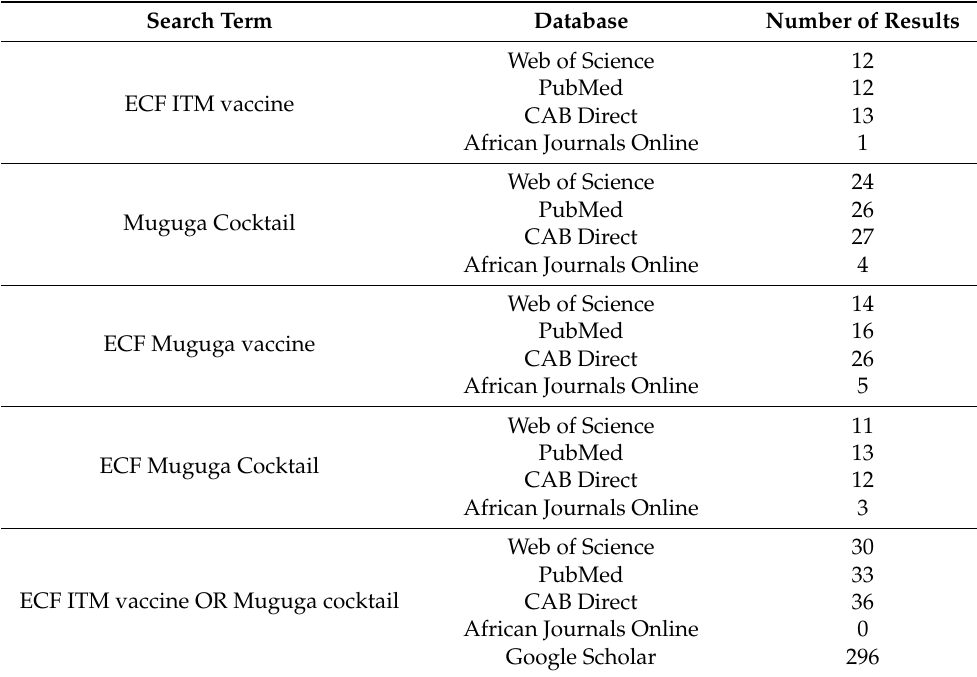
Table 2. Database search terms and